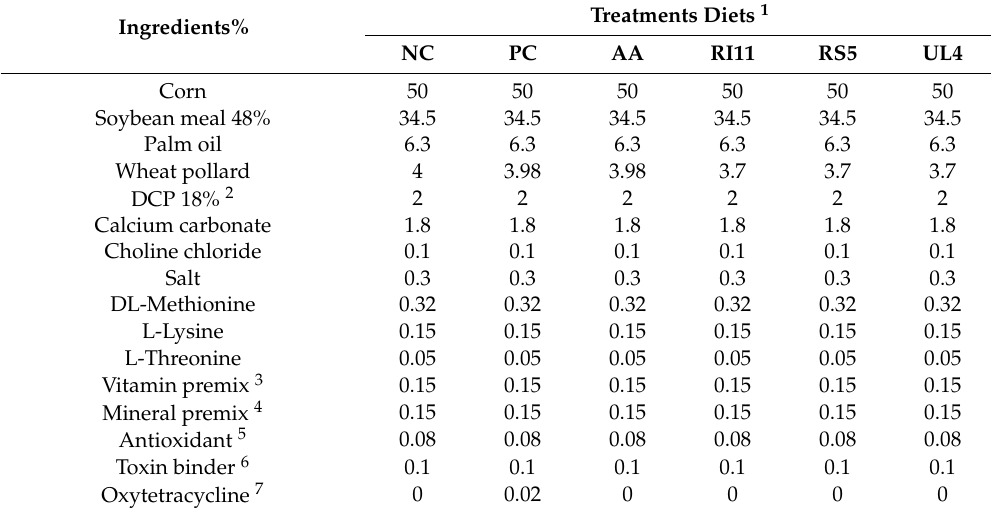
Table 1. Composition and nutrient content of the finisher diets (day